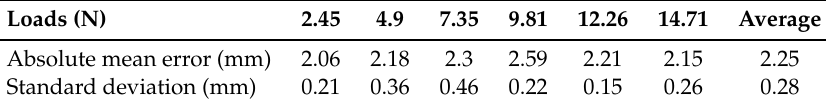
Table 1. Accuracy and Precision of Microsoft Kinect V1.